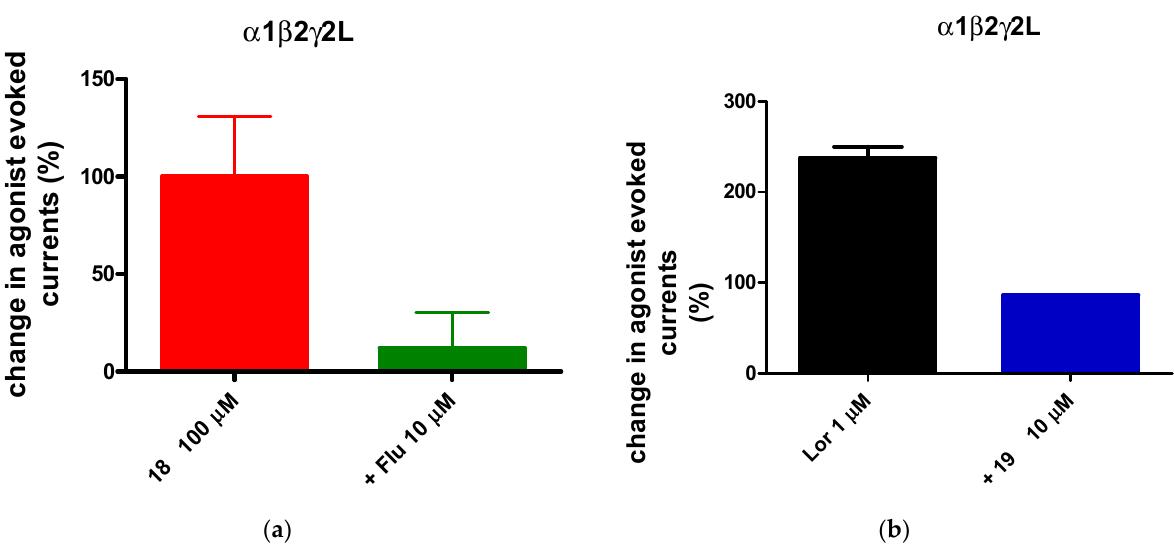
Figure 8. ( a ) Compound 18 antagonized by flumazenil; ( b ) lorazepam antagonized by 19